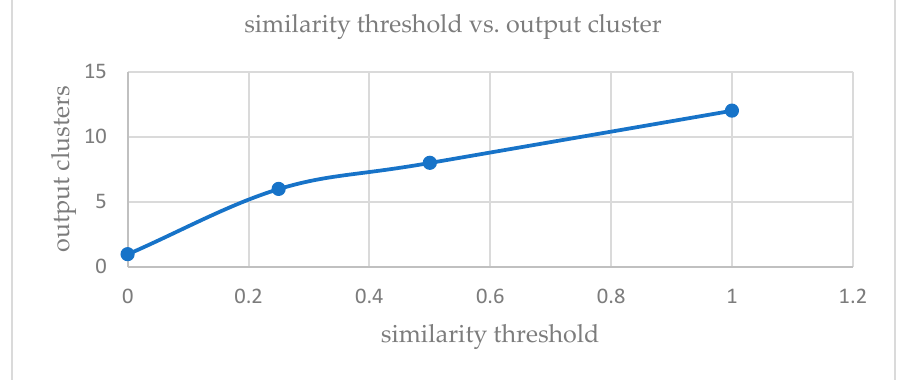
Figure 6. Similarity threshold vs. output clusters using KDDCUP’99.